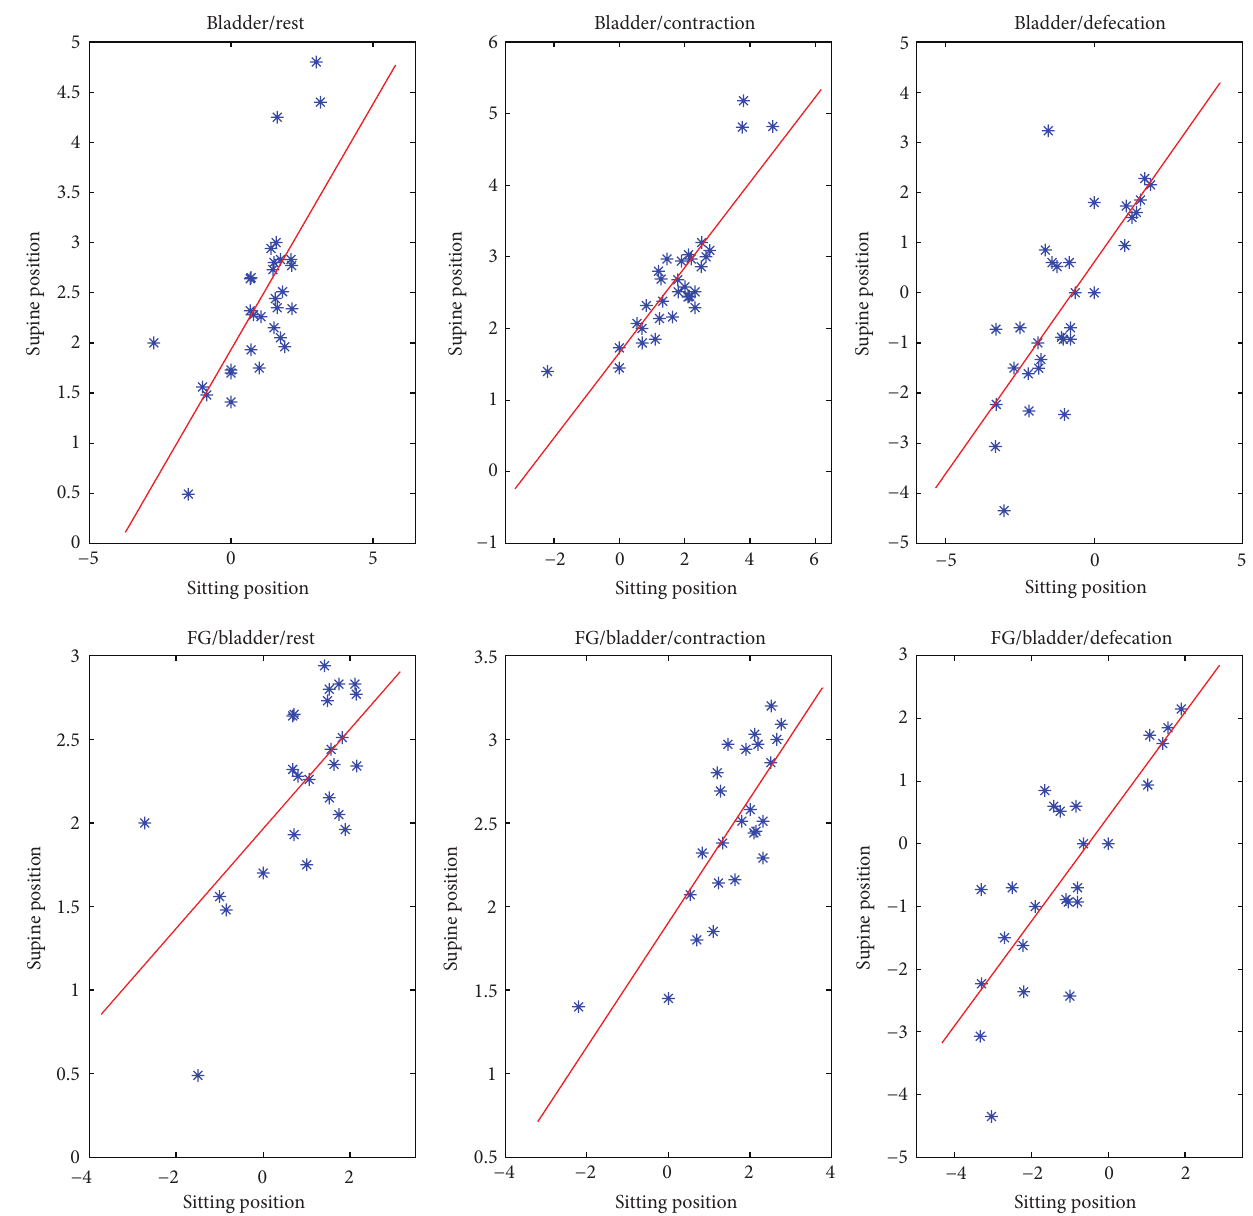
Figure 7: Strong linear correlation for bladder measures in all phases between sitting and supine positions, for all